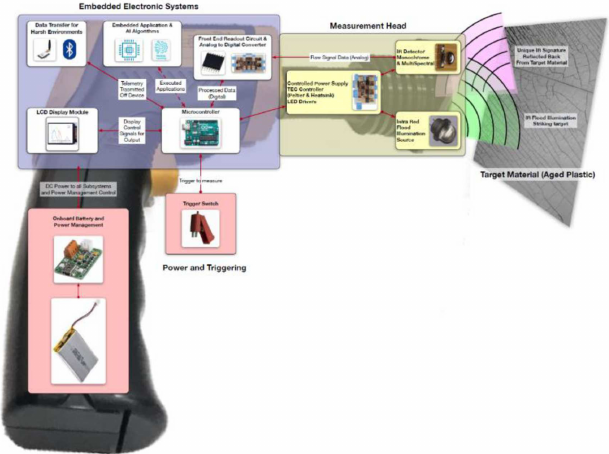
Fig. 2. El-Peacetolero System block diagram.